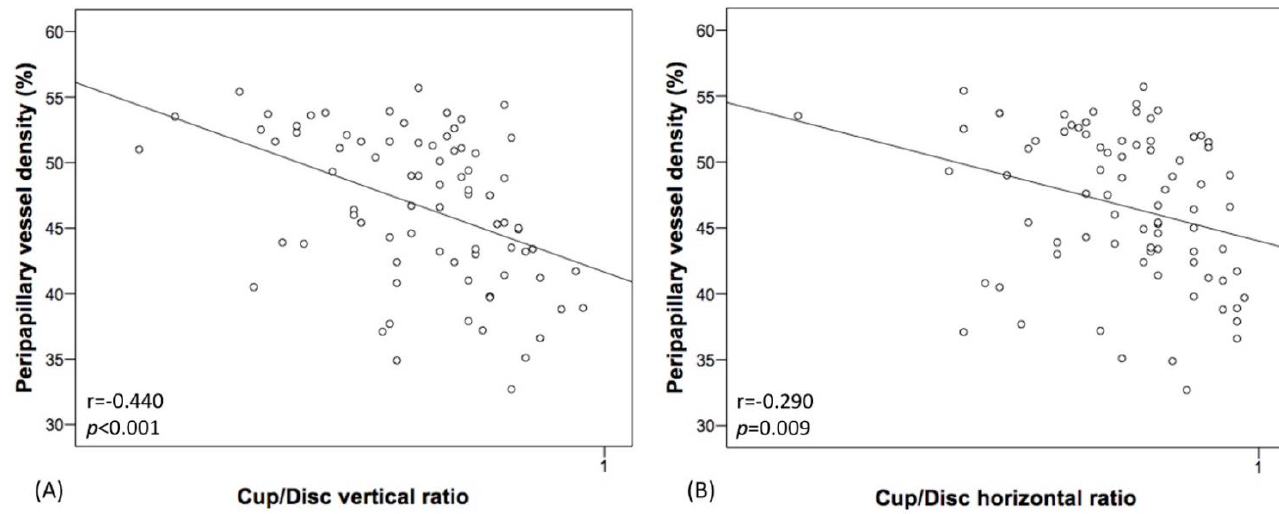
Figure 2. Scatterplots between cup/disc vertical ratio and peripapillary vessel density ( A ); between cup/disc horizontal ratio and peripapillary vessel density ( B ) in patients with normal-tension glaucoma treated with carteolol. (Sample size n = 80, r: Pearson correlation coefficient, p : p value of Pearson correlation)